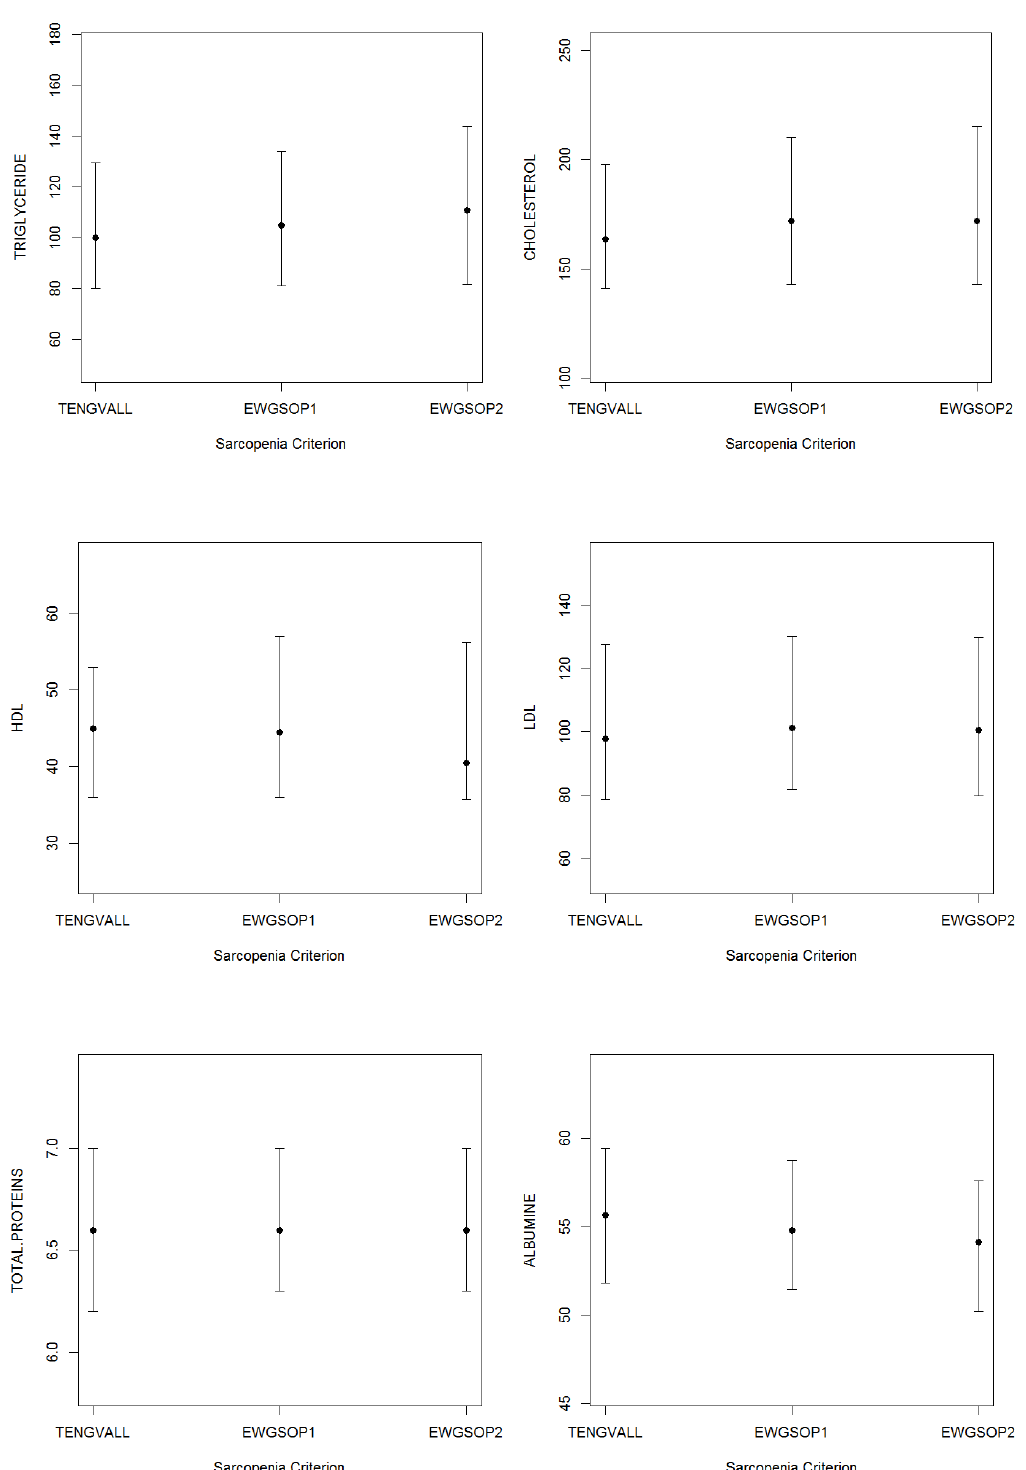
Figure A3. Summary of patients with low ASMI characteristics under each diagnostic criterion. The points represent medians, while lower and upper quartiles are represented by the vertical bars.